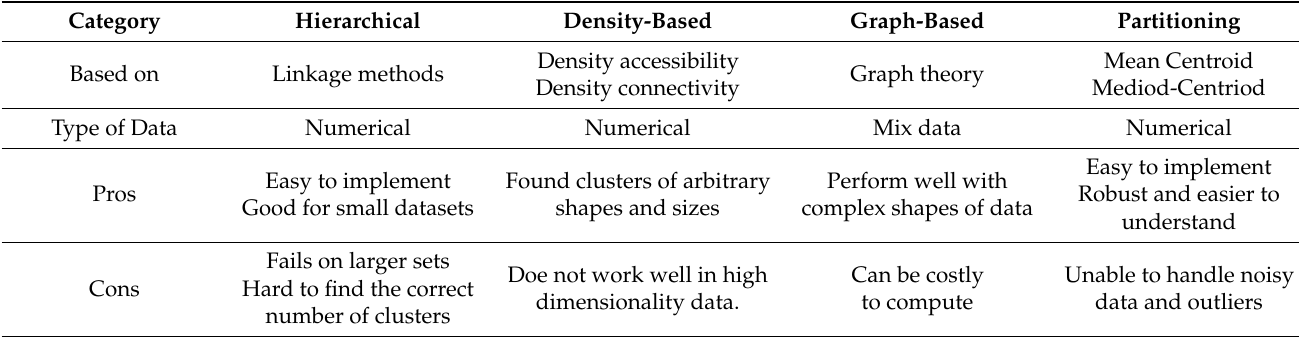
Table 2. Comparison of different clustering techniques.